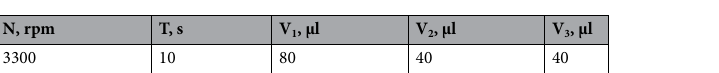
Table 1. Values of technological parameters of control experiments.